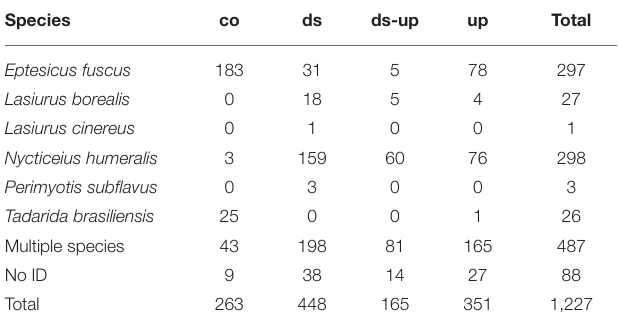
TABLE 5 | Number of bouts, by species and type, for those types used in multivariate logistic regression.